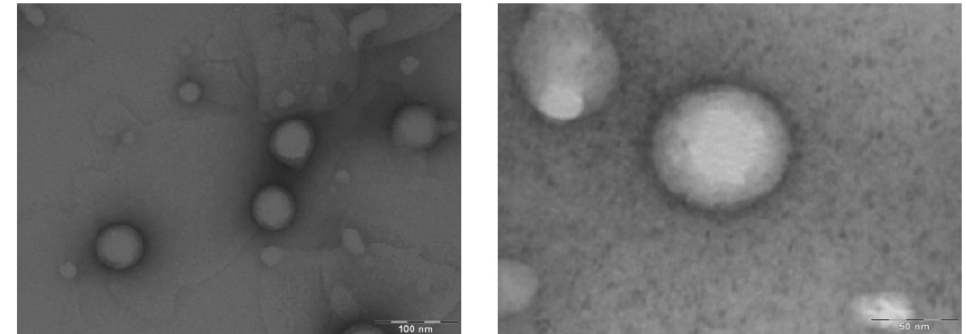
Figure 2. TEM images of DCF NPs observed at different